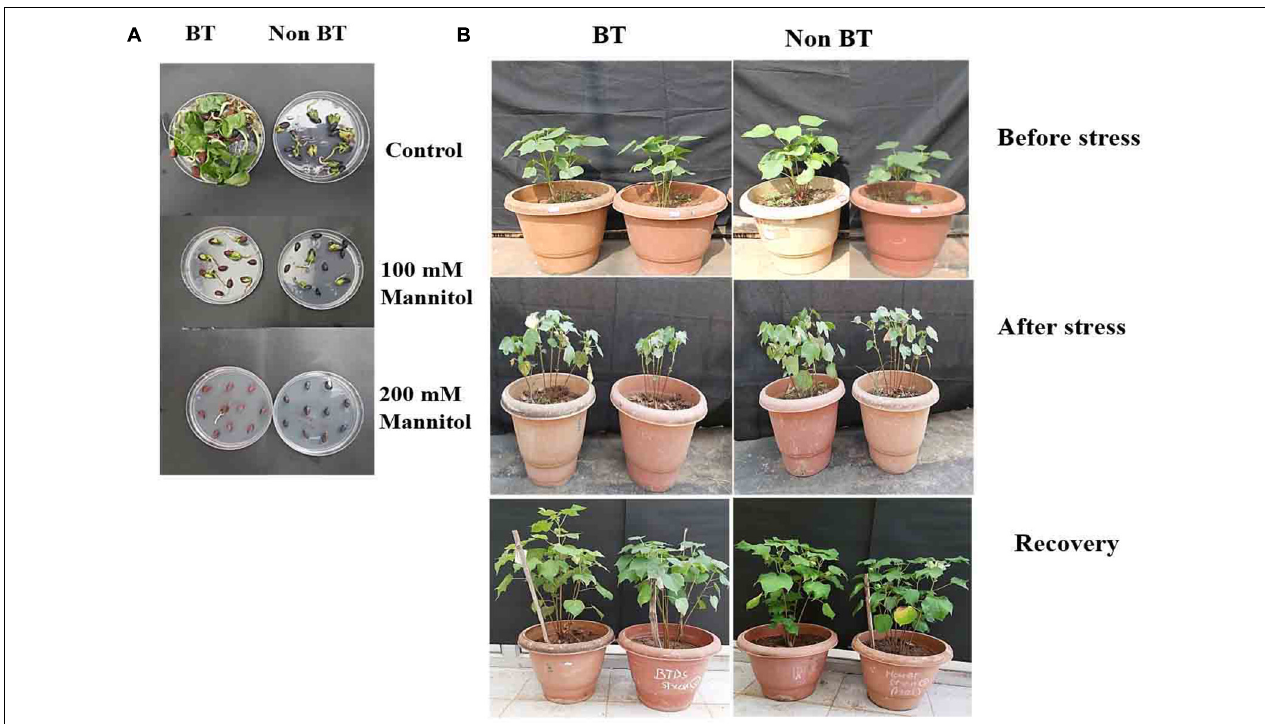
FIGURE 1 | Performance of BT and Non-BT cotton plants against drought stress. (A) BT and Non-BT seed germination Control without mannitol, with 100 mM mannitol and with 200 mM mannitol. (B) BT and Non-BT cotton plants (60–65 days old) were subjected to drought (200 mM) for 15 days at 30 ◦ C. Later, the treated plants were allowed to grow under normal conditions for 20 days and later